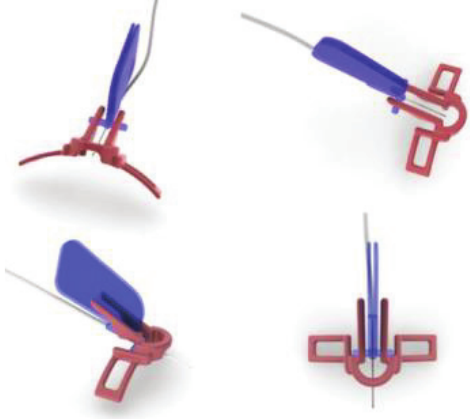
Figure 11: CAD illustrations of the peripheral intravenous injection